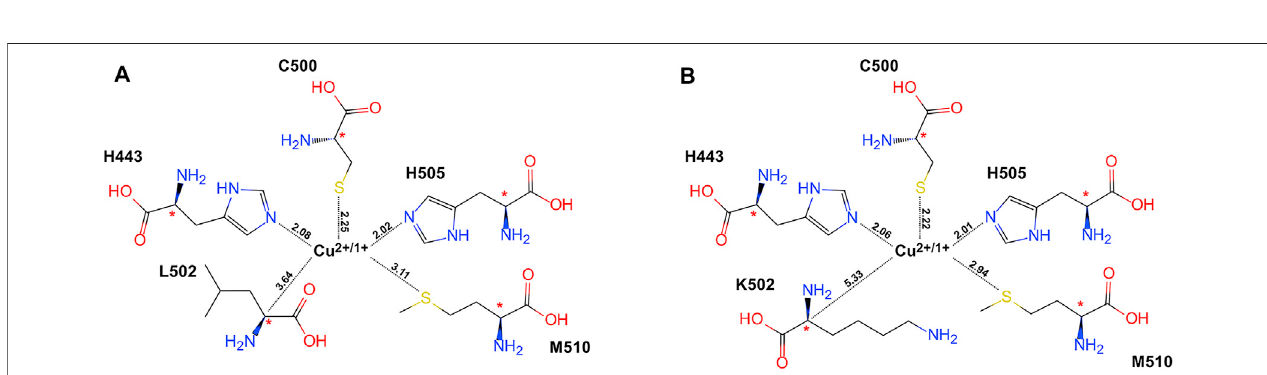
FIGURE 2 | Schematic illustration of the cluster model system based on equilibrated crystallographic data collected by molecular dynamic simulation, with key atoms labeled. The stars indicate the atoms that were frozen during the optimization procedure. (A) WT CueO and (B) the L502K variant. The key distances between cupper atom and amino acids were drawn with dotted lines, and the values were labeled (the unit is Å).